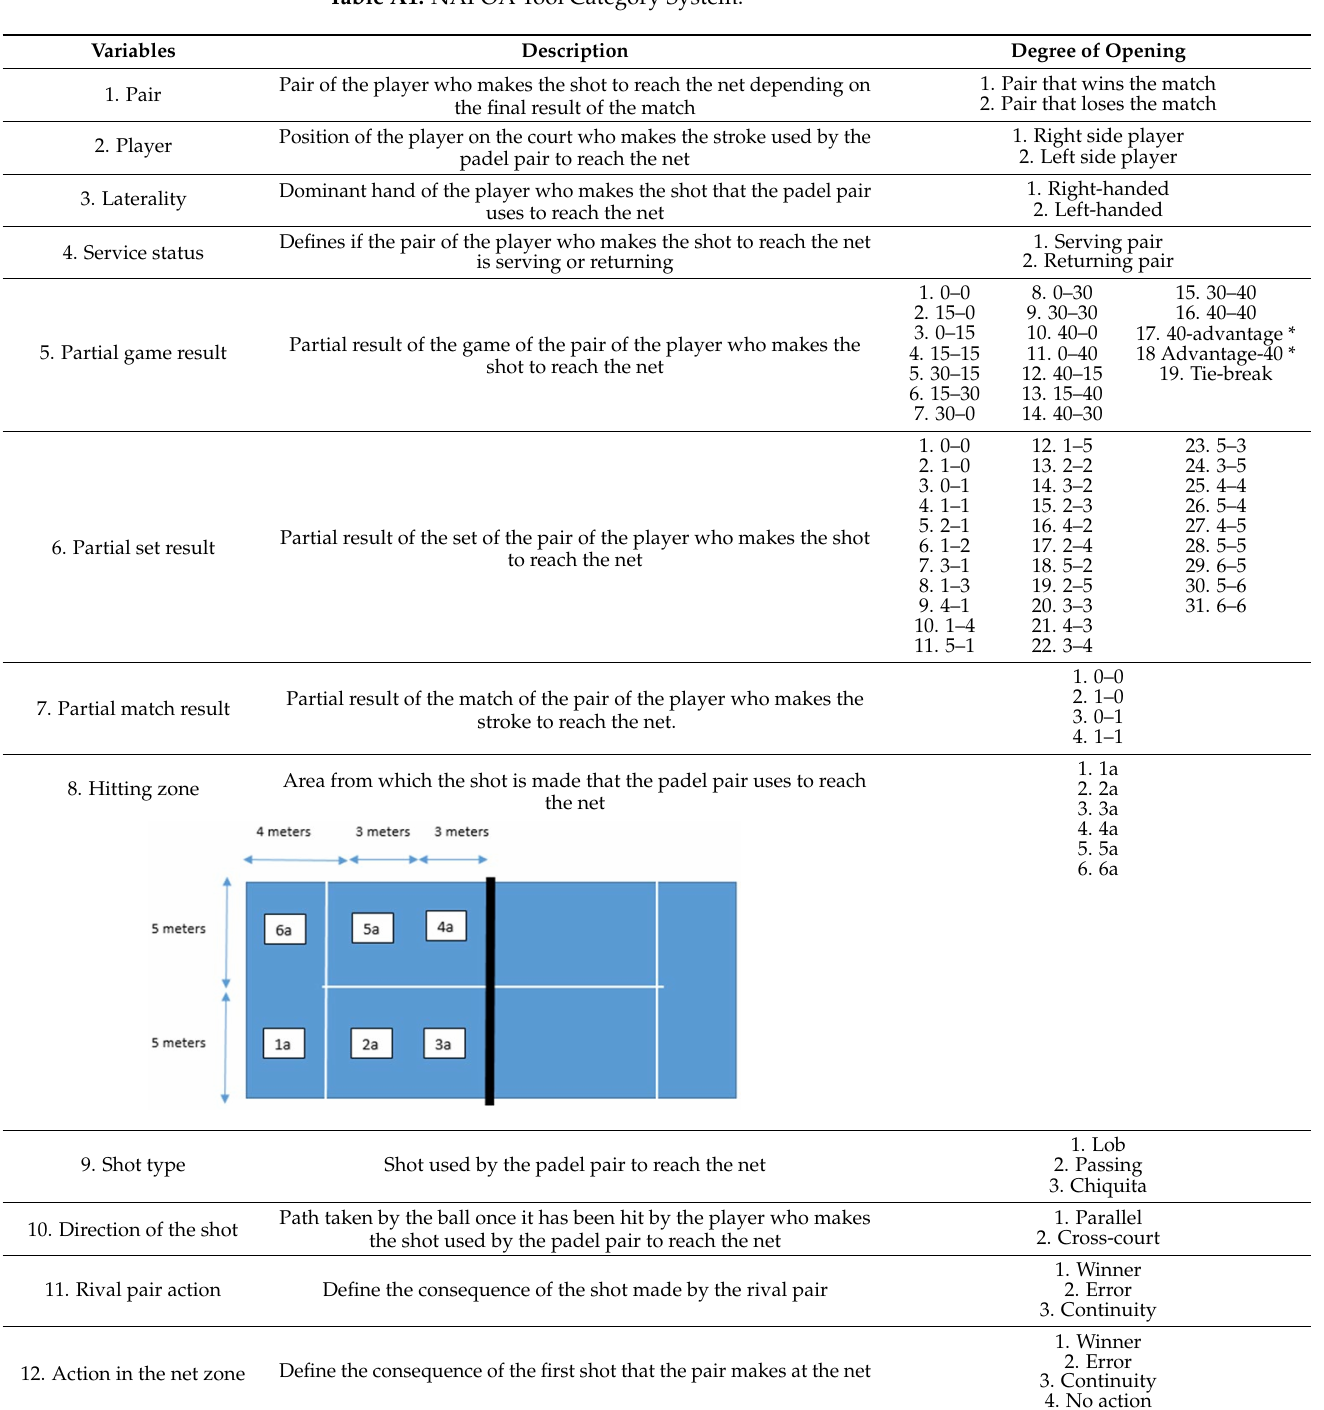
Table A1. NAPOA Tool Category